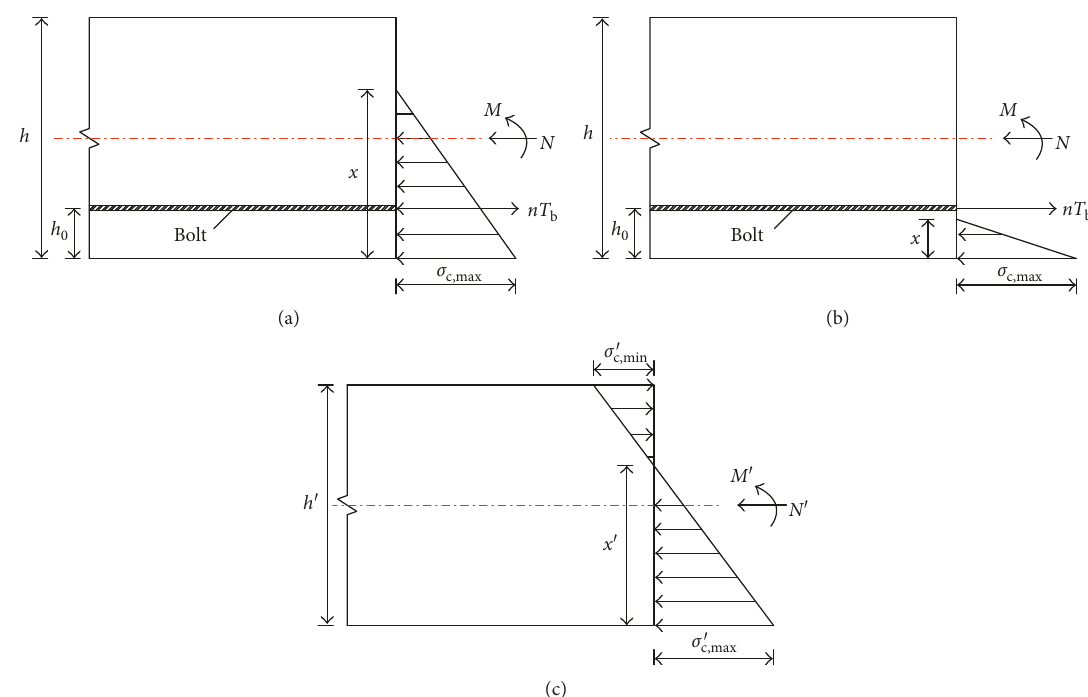
Figure 7: Mechanical characteristic of the joint section under hogging bending moment and large eccentricity pressing condition. (a) Original joint section with the first circumstance. (b) Original joint section with the second circumstance. (c) Equivalent joint